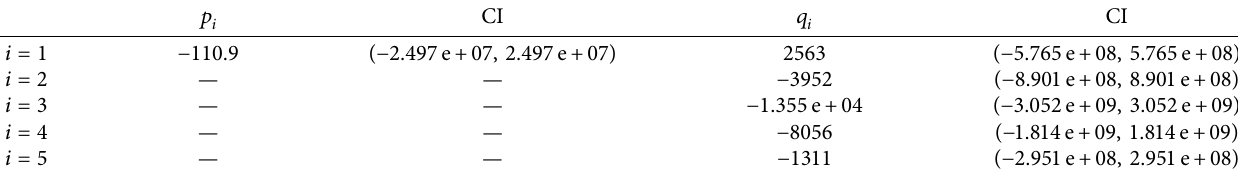
Table 19: Entropy vs. J .